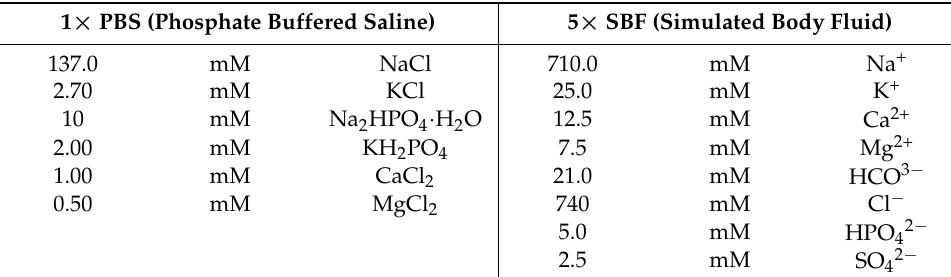
Table 2. Amounts of reagents used to create 1 × PBS and 5 × SBF. 1 × PBS (Phosphate Buffered